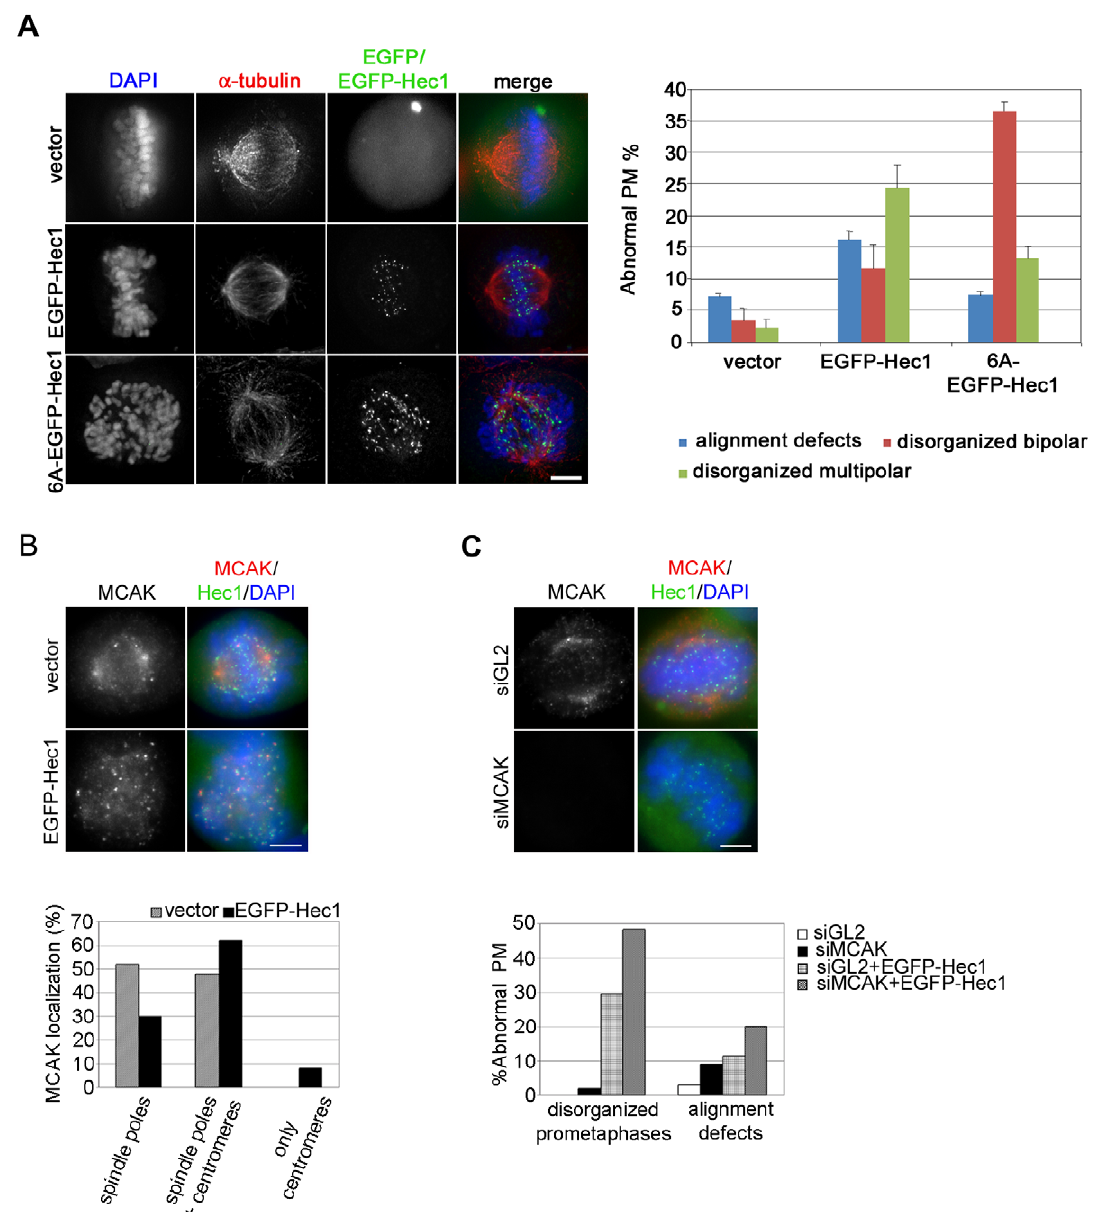
Figure 6. EGFP-Hec1 misattachments allow a partial MT dynamics at kinetochore. (A) EGFP, EGFP-Hec1 or 6A-EGFP-Hec1 (green) expressing cells stained for a -tubulin (red) and DAPI (blue). The vast majority of chromosomes were unaligned in the 6A-EGFP-Hec1 prometaphase. The graph shows a quantitative analysis of prometaphase abnormalities in EGFP (vector), EGFP-Hec1 or 6A-EGFP-Hec1 expressing cells. (B) EGFP and EGFP-Hec1 cells were stained with antibodies to MCAK (red) and Hec1 (only for vector, green), DNA in blue. MCAK accumulated on several centromeres in the EGFP-Hec1 prometaphase. The graph shows a quantitative analysis of MACK localization in mitotic cells (n=50). (C) MCAK (red) staining after control (GL2)- or MCAK-siRNA transfection in EGFP-Hec1 (green) cells. MCAK was efficiently depleted in the EGFP-Hec1 cell. The graph shows the percentage of abnormal phenotypes in GL2- or MCAK-silenced prometaphase/metaphase (PM/M) cells (n $ 100) with or without EGFP- Hec1 expression, as scored by MCAK and DAPI staining; Both alignment defects (P , 0.05, x 2 test) and disorganized prometaphases (P , 0.01, x 2 test) were higher in MCAK-siRNA/EGFP-Hec1 than in GL2-siRNA/EGFP-Hec1 cells. Bars, 5 m m.